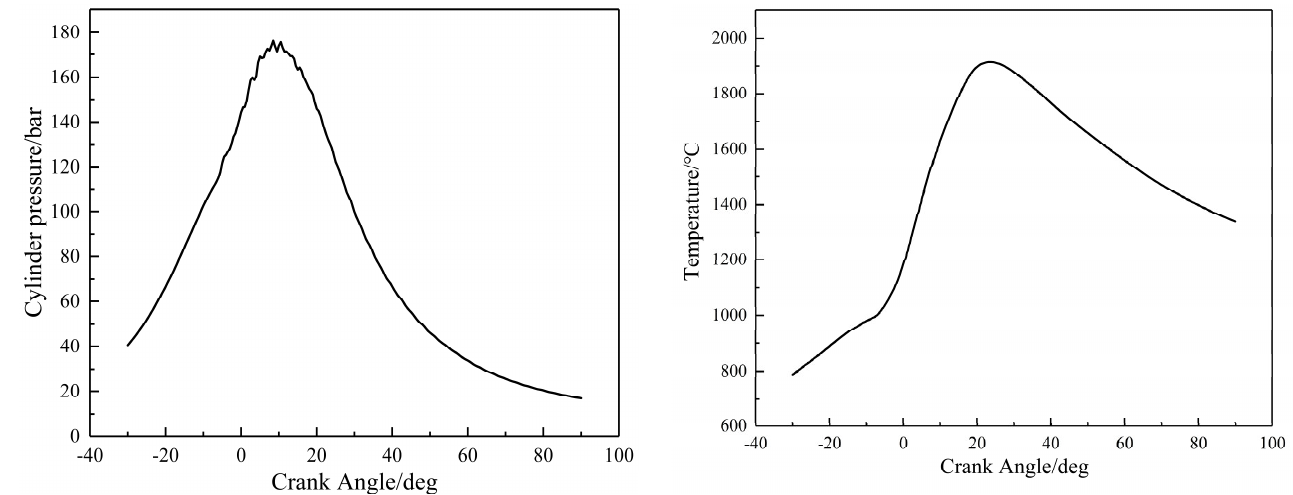
Figure 8. Test−measured cylinder pressure and temperature. Figure 8. Test − measured cylinder pressure and temperature.